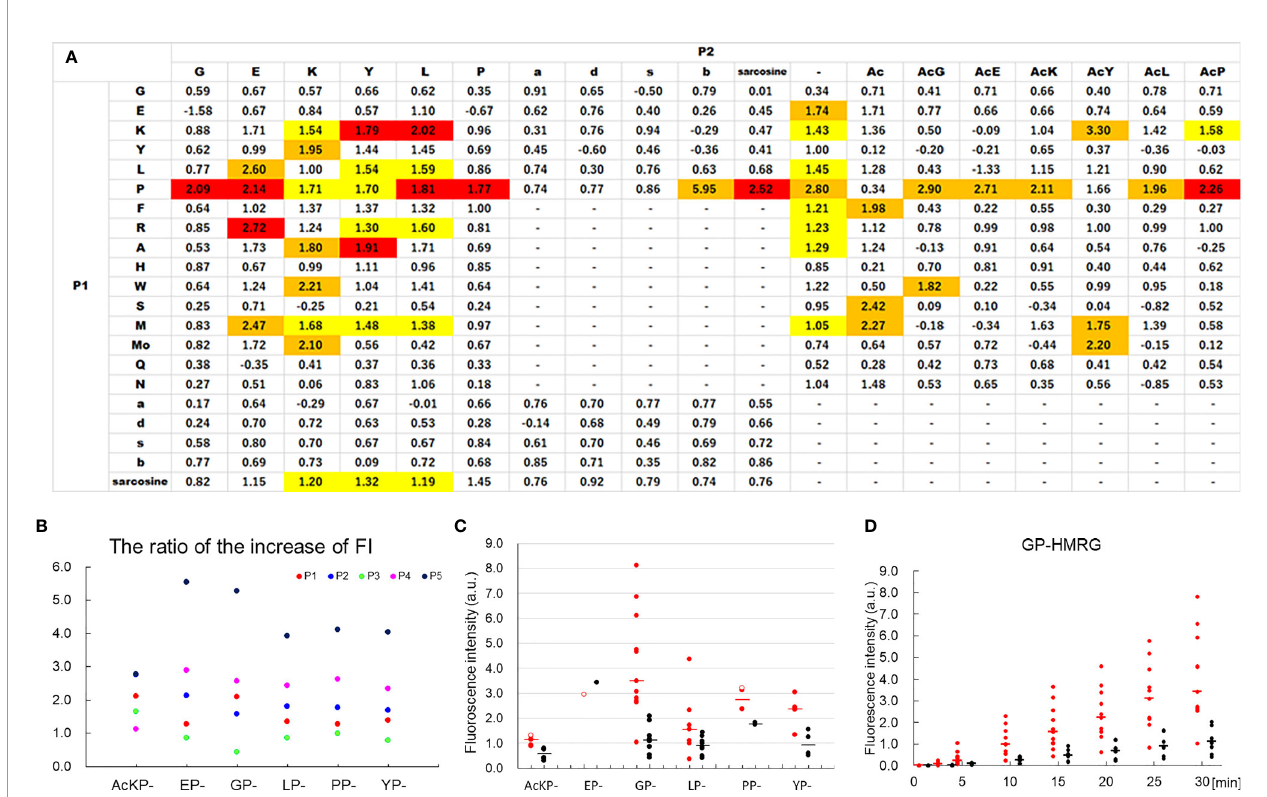
FIGURE 1 | Analysis of FI values of candidate probes in the primary and secondary selections using lysates and tissue fragments obtained from patients with pancreatic cancer. (A) The heatmap of the probe library with median differences/ratios of FI increase between cancer and non-cancer lysates for 309 candidate probes. The values ranked in the upper 90 percentile were indicated in yellow (FI differences), orange (FI ratios), or red (both). The number represents the median ratio of FI increase. P1 and P2 correspond the positions of amino acid residues of the probe P2-P1-HMRG. The lowercase letters represent the optical isomers of the amino acids. (B) The ratio of the FI increase between cancer and non-cancer lysates obtained from fi ve patients using the selected six HMRG-based fl uorescence probes. Probes with a dipeptide with prolyl residue at the P1 position (XaaP-HMRG) tend to show suf fi cient FI ratios between cancer and non-cancer samples. (C) The FI increase 30 min after addition of probe to tissue fragments. The difference in FI increase for 30 minutes tended to be high for GP-HMRG (median [range], 3.49 [1.03 – 8.11] a.u. vs 1.12 [0.42 – 2.09] a.u., P = 0.002; Wilcoxon ’ s rank-sum test), followed by AcKP-HMRG (1.14 [0.87 – 1.29] a.u. vs 0.58 [0.29 – 0.78] a.u., P = 0.008), YP-HMRG (2.39 [1.33 – 3.04] a.u. vs 0.93 [0.52 – 1.54] a.u., P = 0.043), and LP-HMRG (1.55 [0.35 – 4.35] a.u. vs 0.91 [0.40 – 1.45] a.u., P = 0.093). The number of the cancer/non-cancer fragments (red fi lled circle/black fi lled circle) used in this evaluation was: AcKP- (5/6), EP- (0/1), GP- (11/8), LP-HMRG (7/8), PP- (2/2), and YP-HMRG (4/4). In one case, cancerous samples submitted to fl uorescence imaging using EP-, PP-, and AcKP-HMRG were proved to be pancreatitis by fi nal pathological evaluations (red empty circle) and excluded from the statistical analyses. Bars indicate median values. (D) Trends of FI increases of cancer tissues and noncancerous tissue fragments obtained from the 11 patients after the administration of GP-HMRG. Bars indicate median